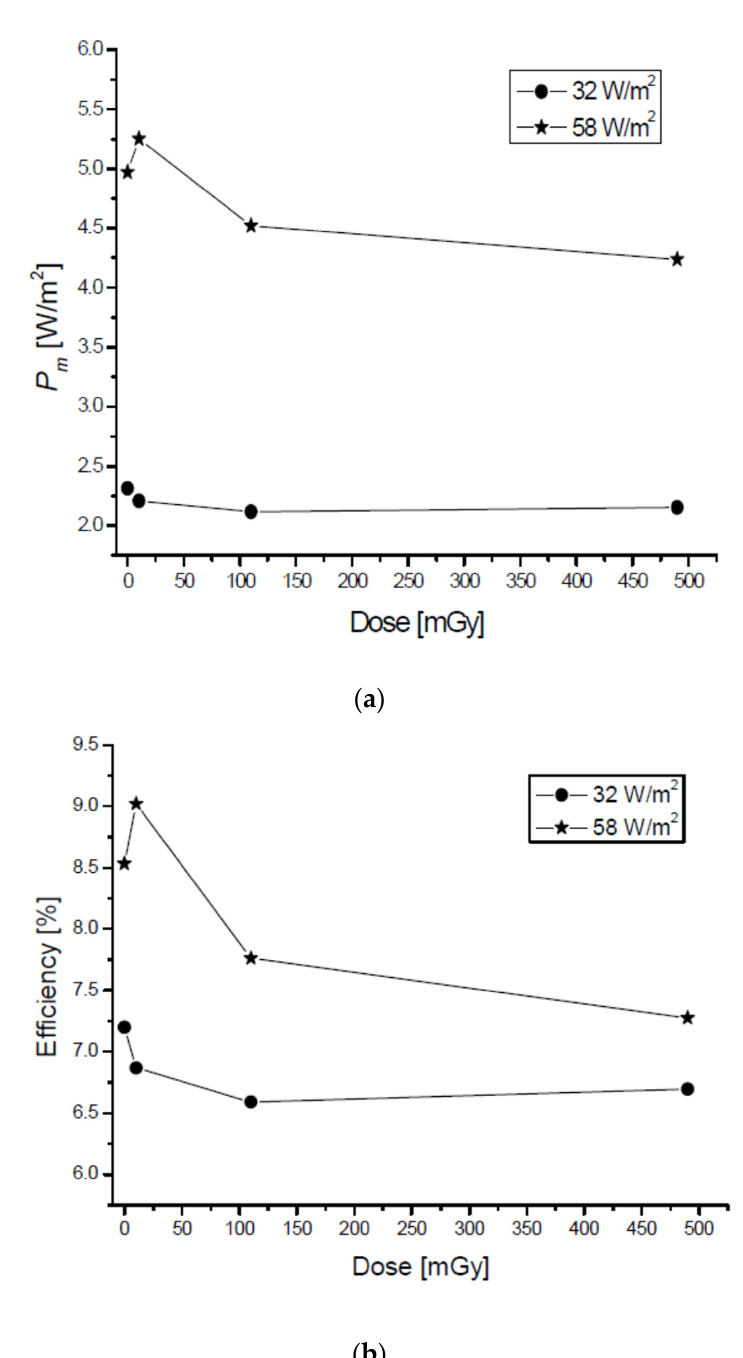
Figure 5. Dependence of the maximum power ( a ) and efficiency ( b ) on doses of gamma irradiation. Reproduced with permission from [118].